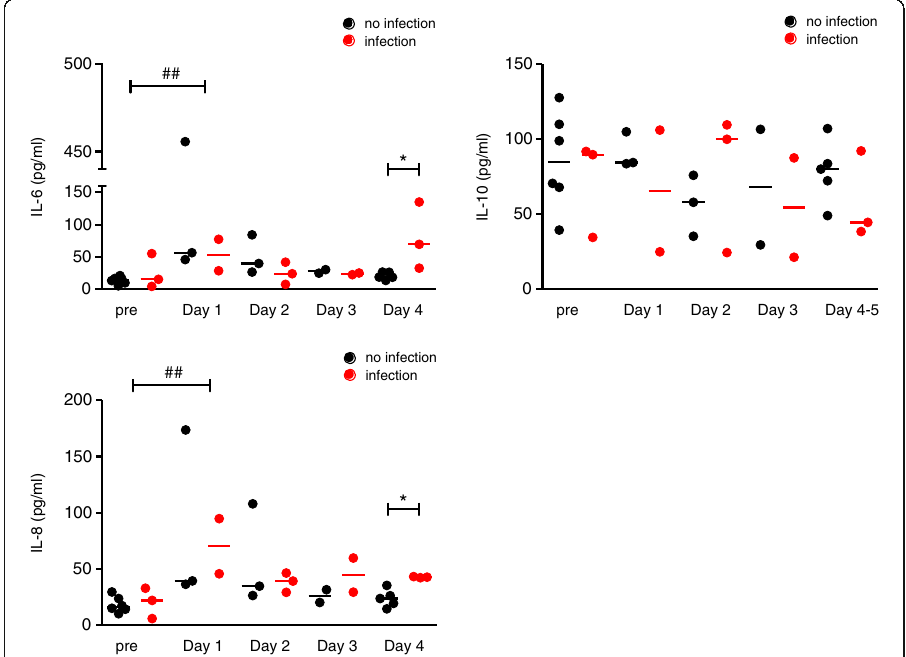
Fig. 2 Circulating levels of IL-6, IL-8 and IL-10 in neonates after cardiopulmonary bypass. The Kruskal – Wallis test was used for comparisons of multiple groups, with Dunn ’ s multiple comparisons test for intergroup comparisons (preoperatively, 1, 2, 3 and 4 days after CPB) (## p <0.01). The Mann – Whitney test was used to compare the infected versus non-infected patients on day 4 (* p <0.05)